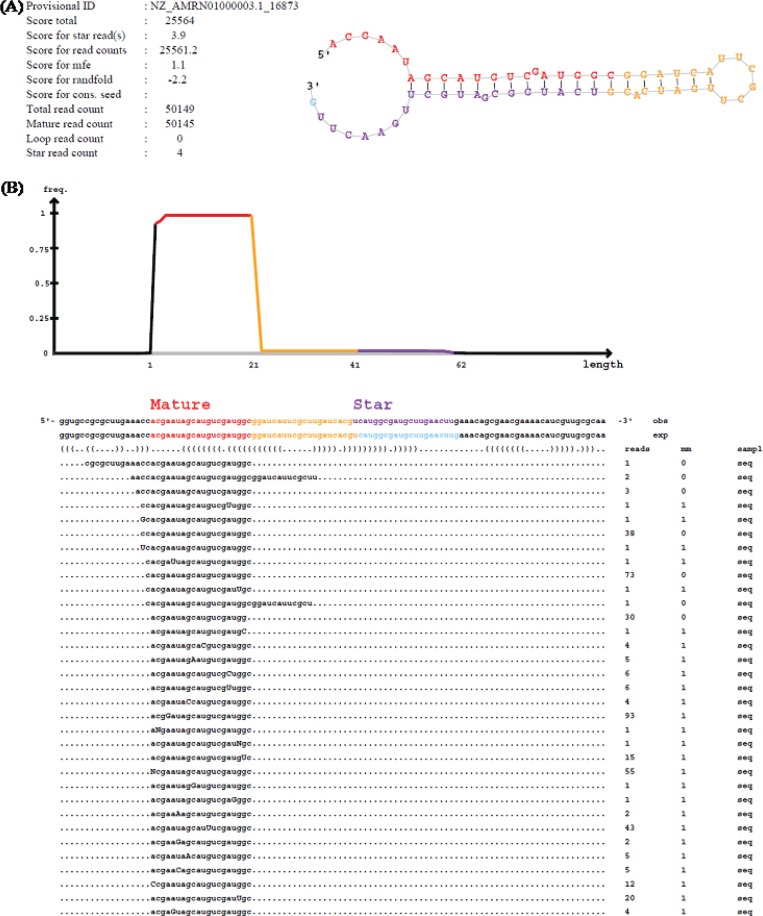
An example of miRDeep output for T.prof_5p_16873.(A) Predicted secondary structure of miRNA precursor with the mature, star and loop sequences (highlighted in red, yellow and purple, respectively). The scores associated to the miRNA, the read counts for mature, star and loop sequences and the total read count are also given. (B) Sequences of the predicted miRNA precursors mapped to the mature, star and loop sequences on the genome (obs line) and the experimental sequence reported in miRBase (exp line). The frequency (reads column) and mismatches of the read with the genomic sequence (mm column) are also given with the mismatches shown in capital letters.